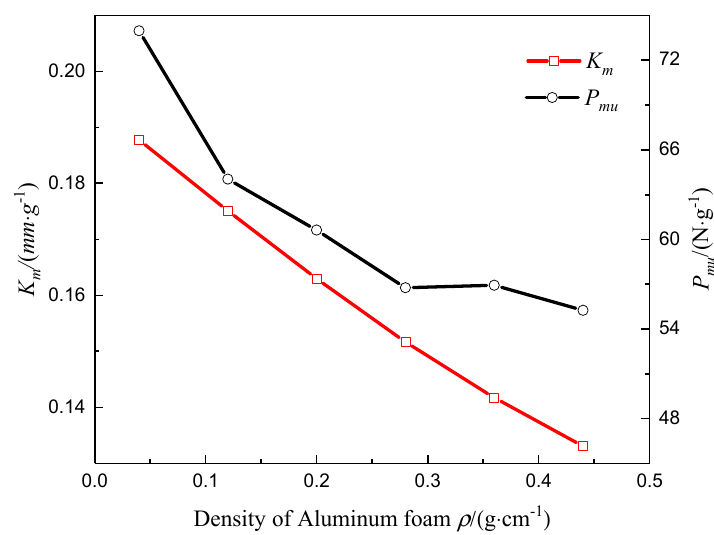
Figure 23. Specific stiffness K m and specific load P mu changing with the wall thickness of aluminum honeycomb.